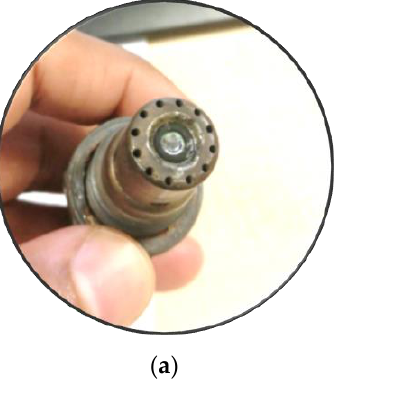
Figure 2. APU igniter and faults: ( a ) actual igniter with eroded tip; ( b ) nominal limit of erosion; ( c ) burnt outer shell fault, adapted from [10].